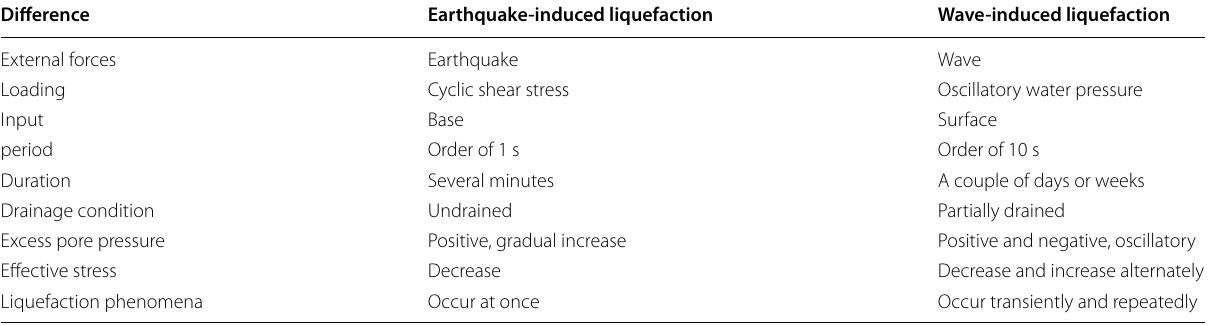
Table 3 Difference between wave-induced liquefaction and seismic liquefaction (modified from Zen and Yamazaki 1990a; Sumer et al.